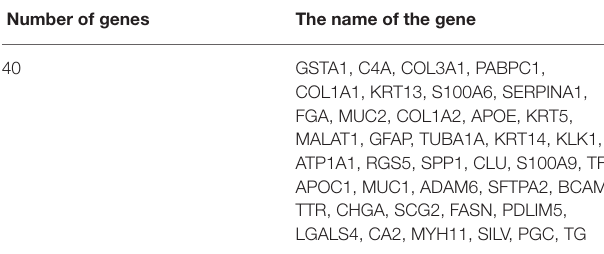
TABLE 7 | Selected